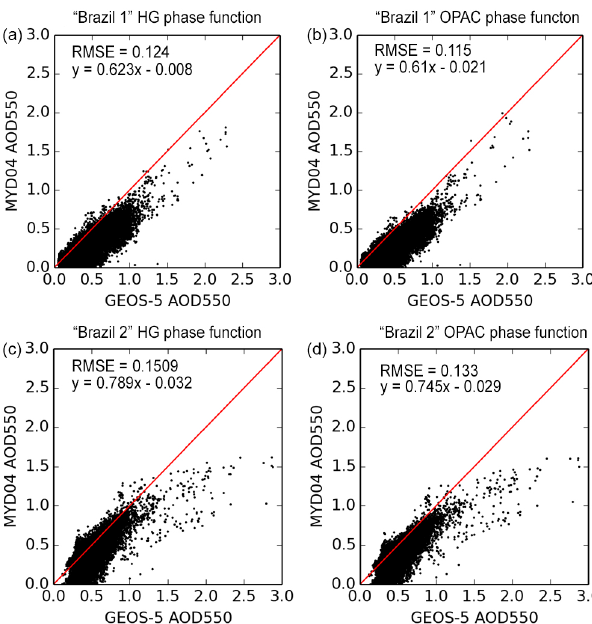
Figure 5. Effect of aerosol phase function shape on Brazil smoke cases. Panels (a) and (c) show the runs with HG phase function. Panels (b) and (d) show use of the OPAC composite phase